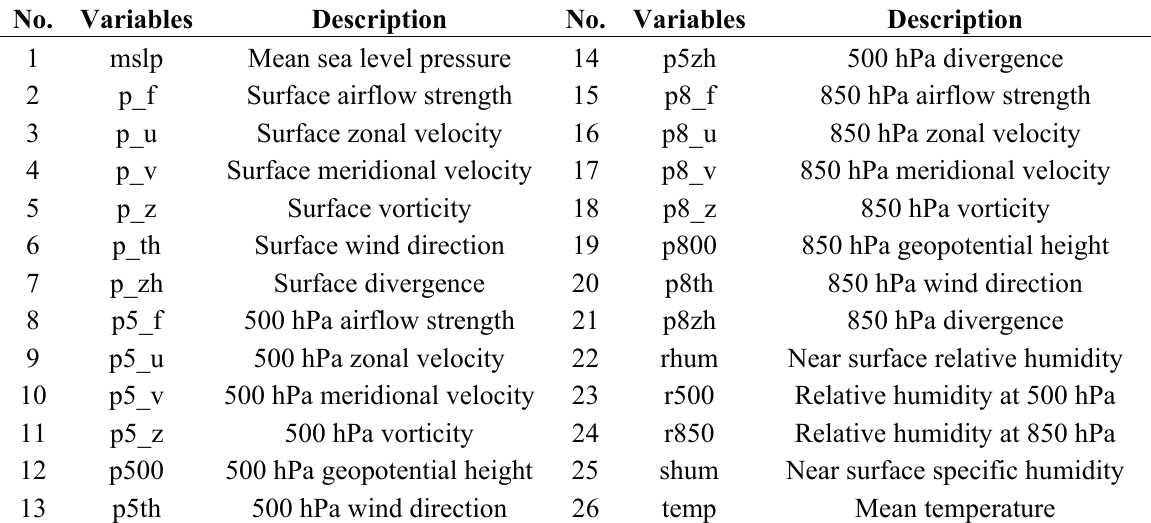
Table 2. Description of 26 NCEP variables used for predictor